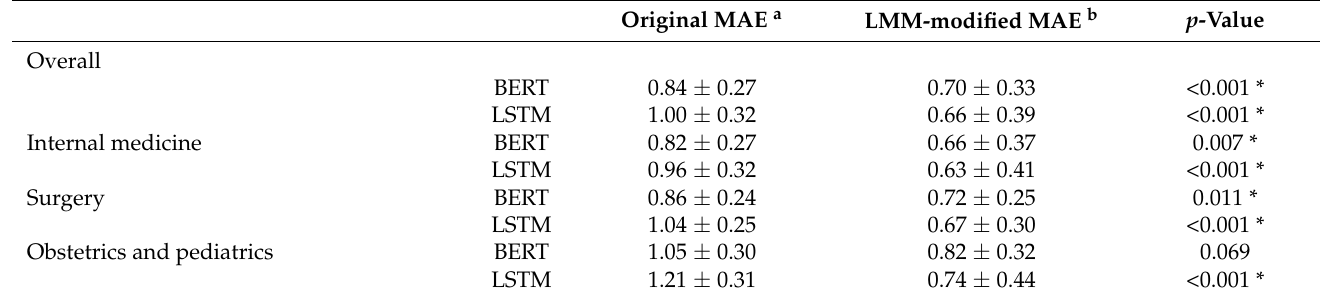
Table 3. The difference between the original AI/LMM-modified score and the expert